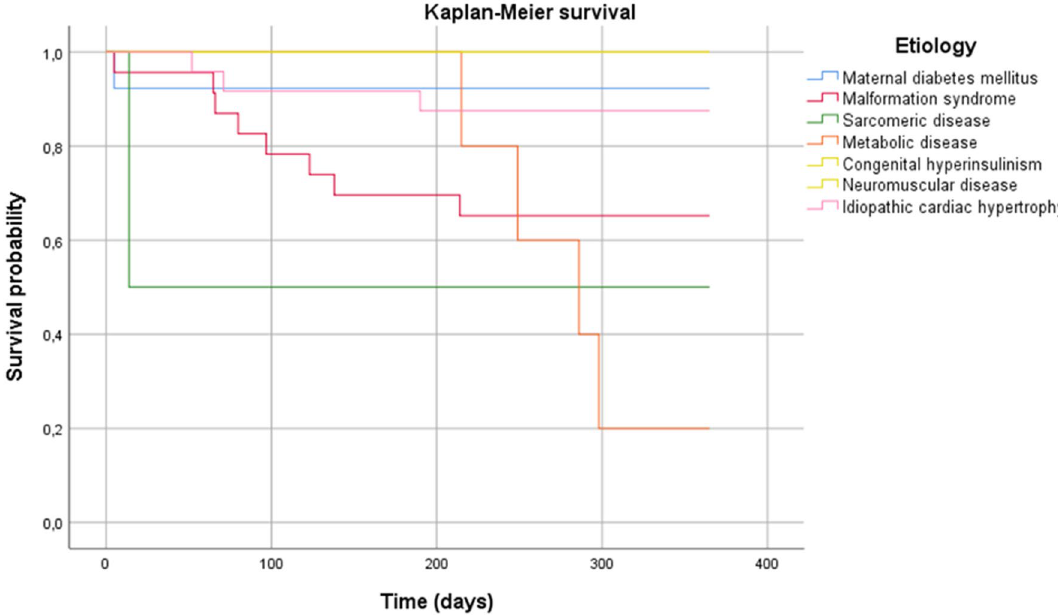
Figure 3. One-year survival of underlying causes of cardiac hypertrophy in